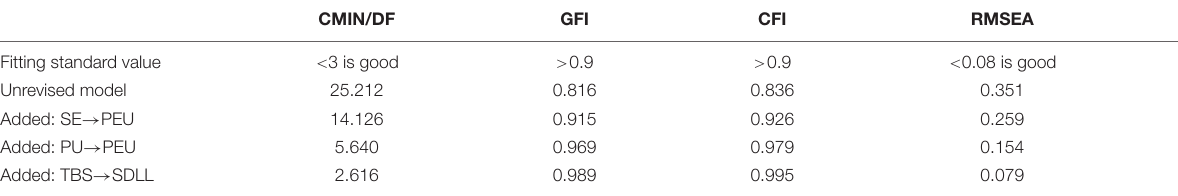
TABLE 4 | Comparison of fitting test value and fitting standard value of the modified hypothesis model. CMIN/DF GFI